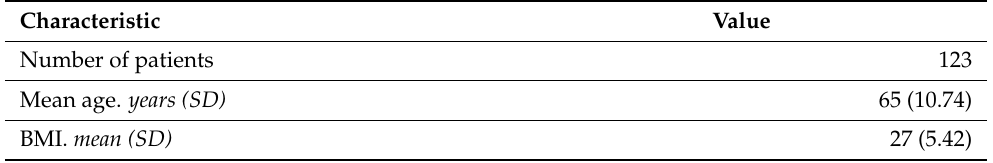
Table 1. Patient’s